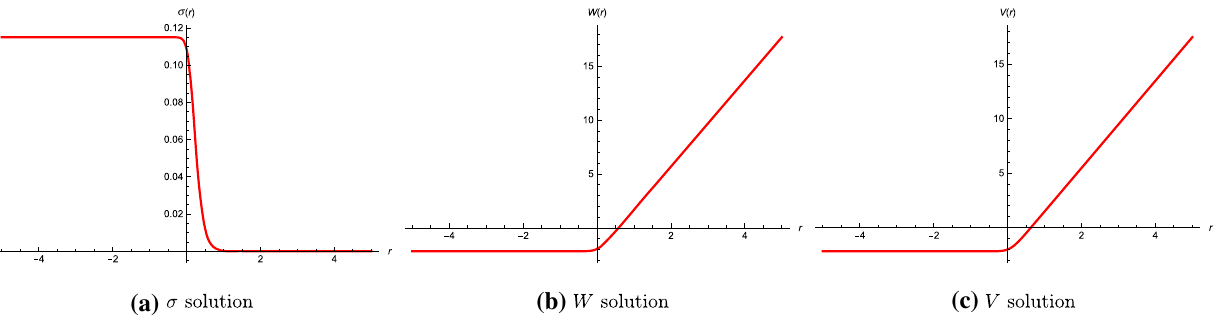
Fig. 9 An RG flow from SO ( 4 ) N = ( 1 , 0 ) SCFT in six dimensions to two-dimensional N = ( 2 , 0 ) SCFT with SO ( 2 ) R symmetry dual to AdS 3 × H 2 × H 2